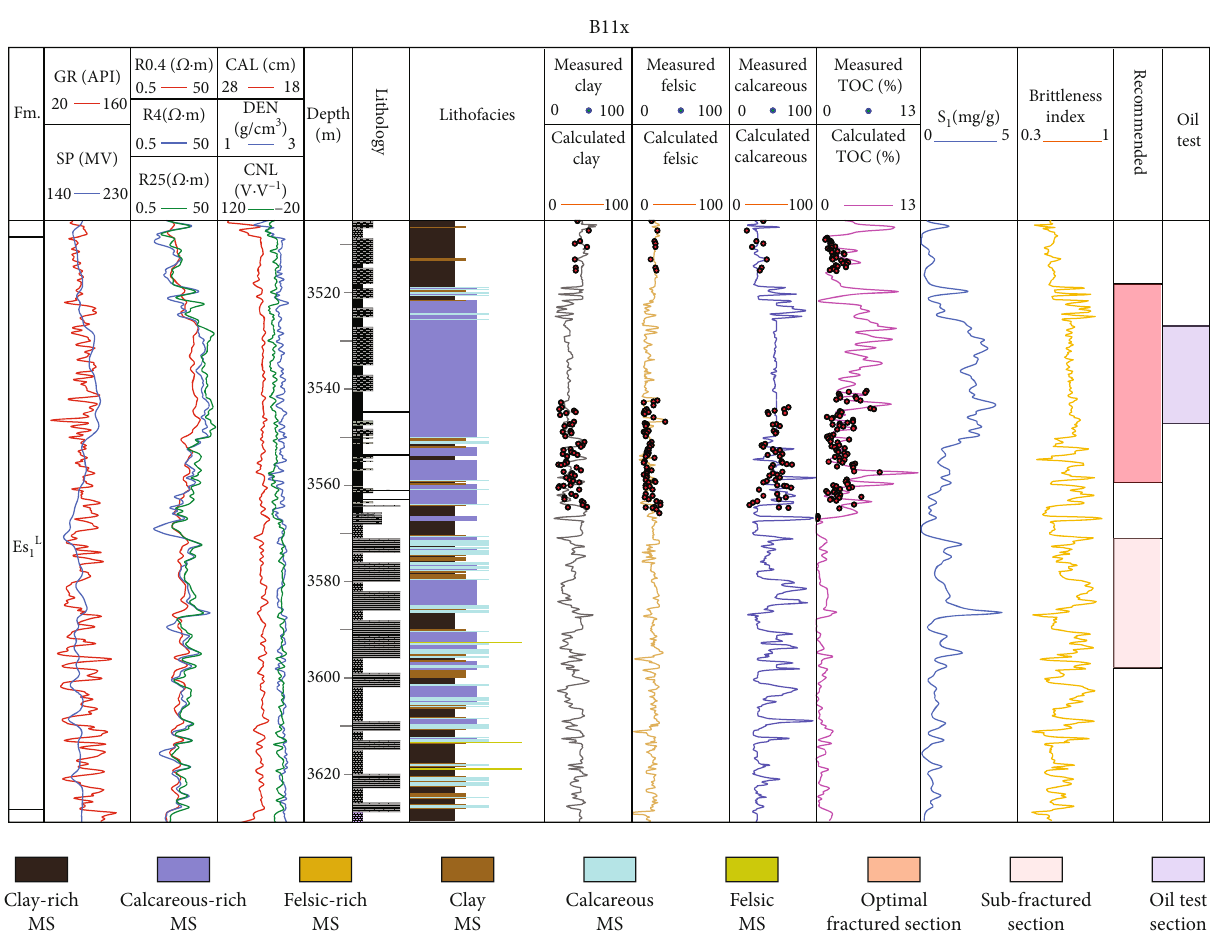
Figure 13: Comprehensive evaluation of longitudinal fractured section in well